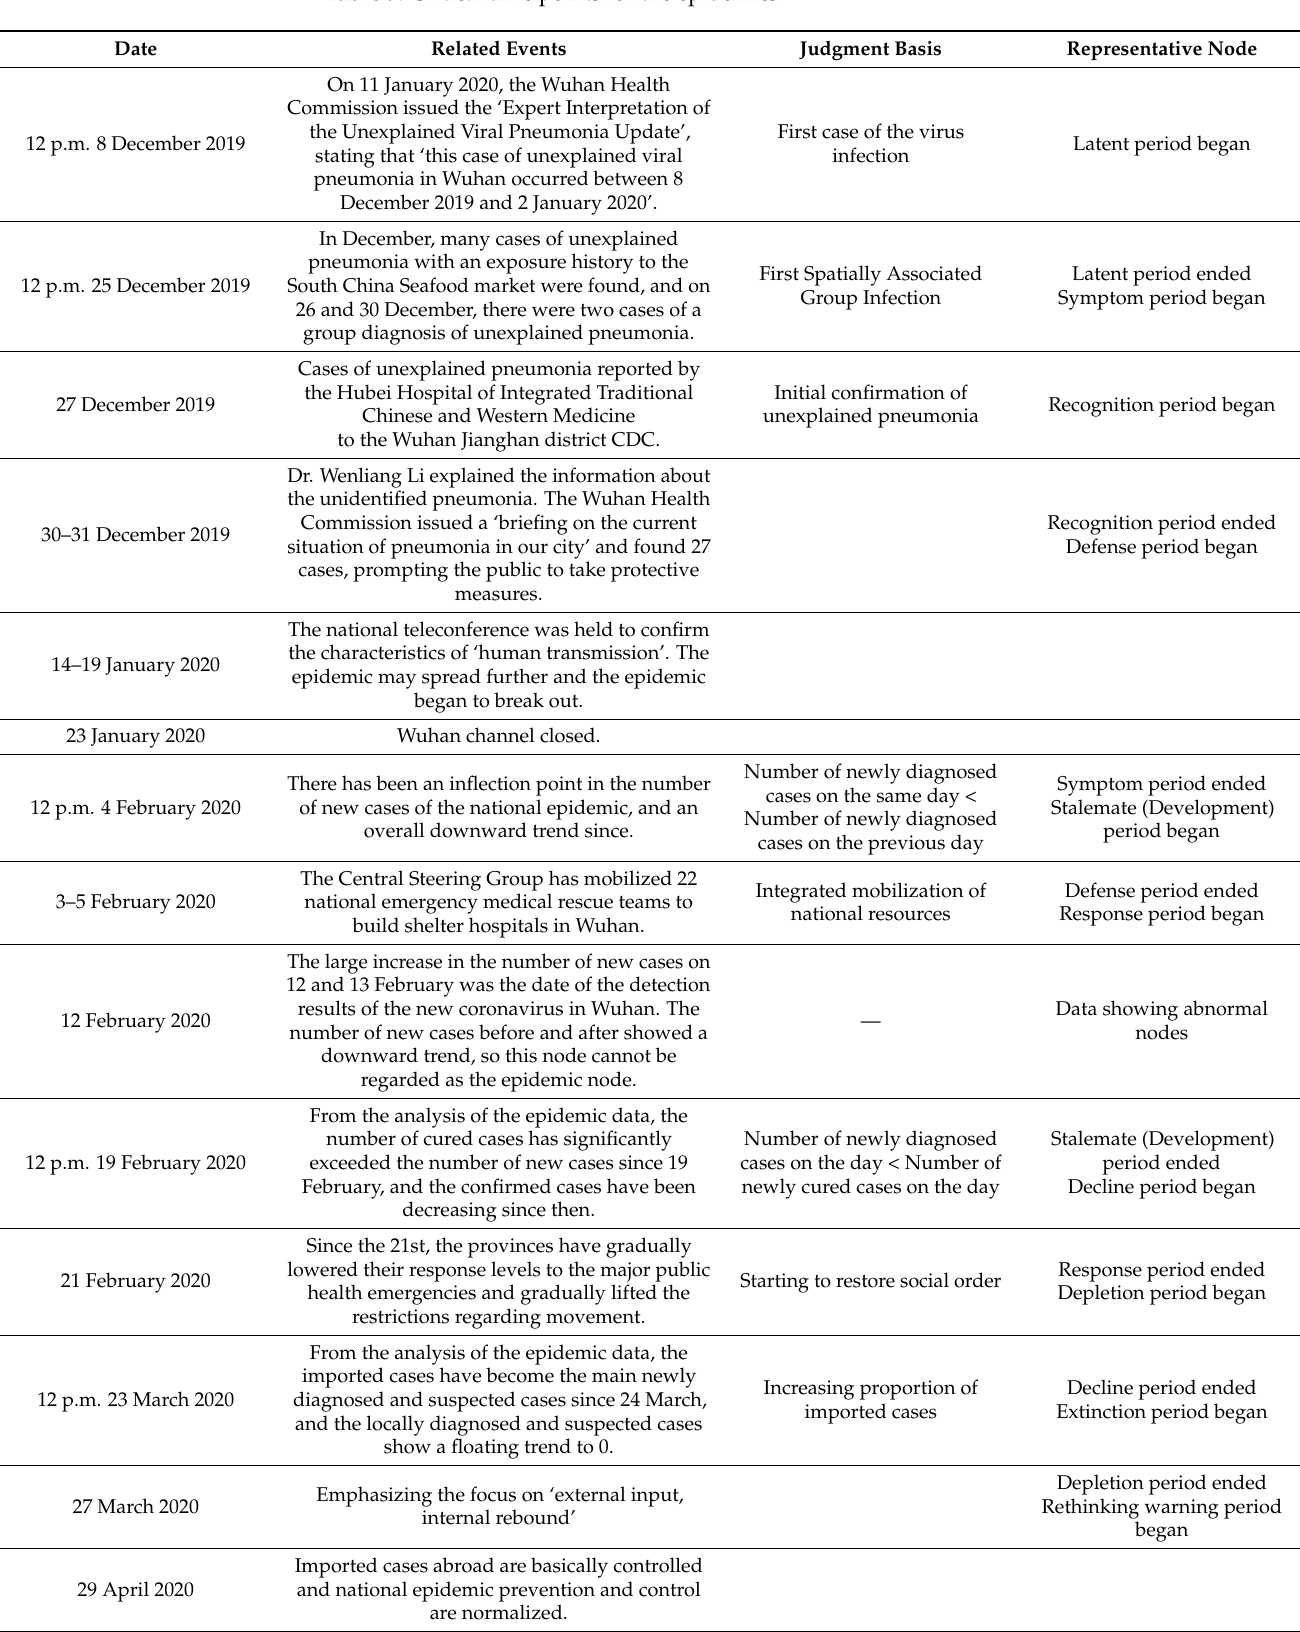
Table 9. Critical time points for the